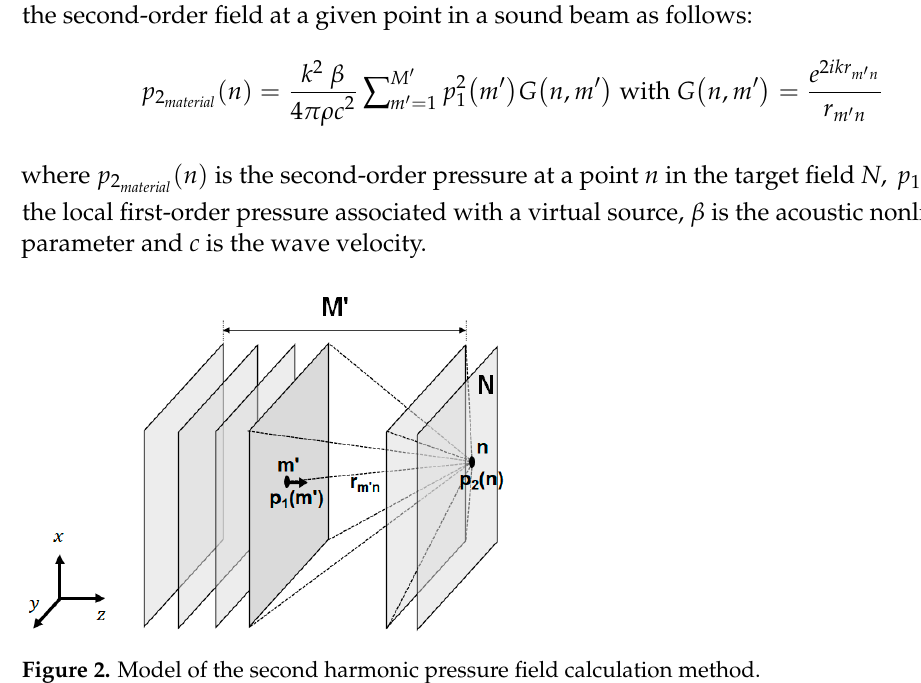
Figure 1. Basic concept of the distributed point source method.